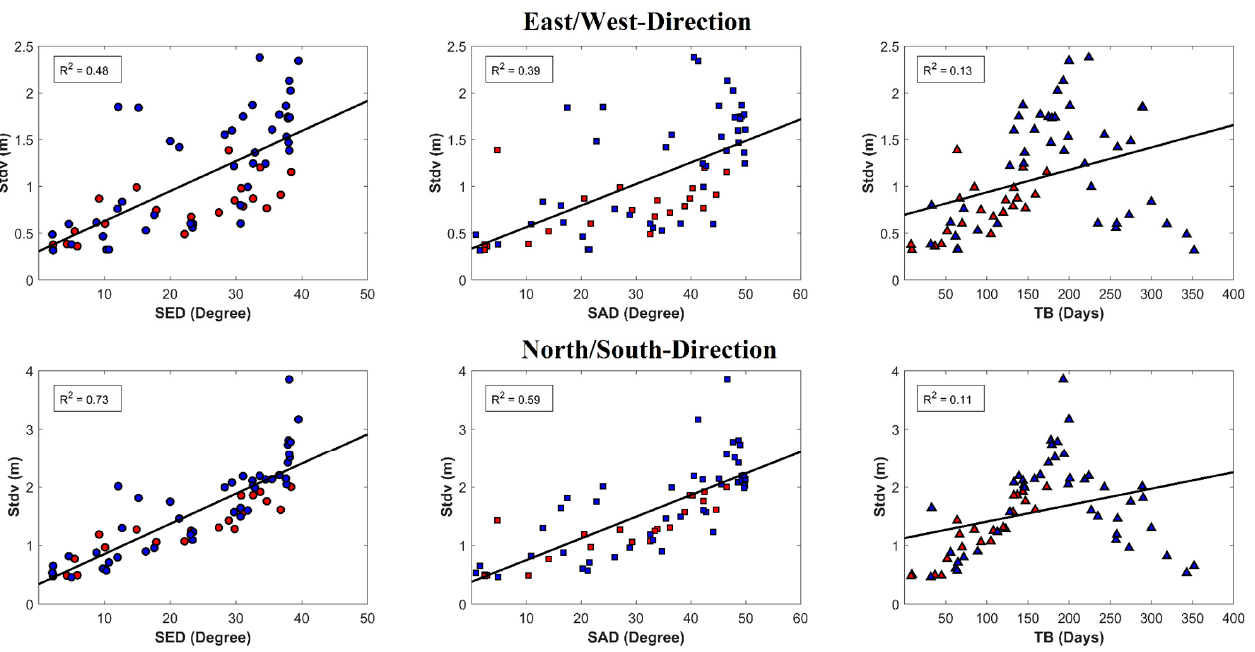
Figure 6. Relationship between SED, SAD, TB, and uncertainties in the East/West direction ( top ) and North/South direction ( bottom ) for all the POT results. The red and blue colour indicate the first and second time series POT results, respectively. The circle, square, and triangle markers represent the SED, SAD, and TB, respectively. The black lines represent the best linear fits.